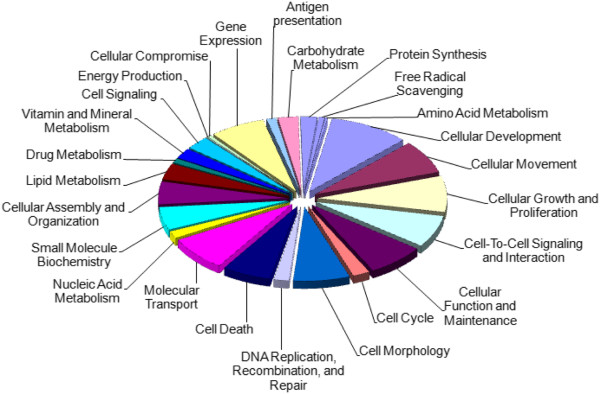
Molecular and cellular functions associated with genes up-regulated in lymphocytes in response to rapamycin treatment. The chart shows the number of genes, expressed as a percentage of the total number, involved in each of the molecular and cellular functions deemed significant by IPA Ingenuity.